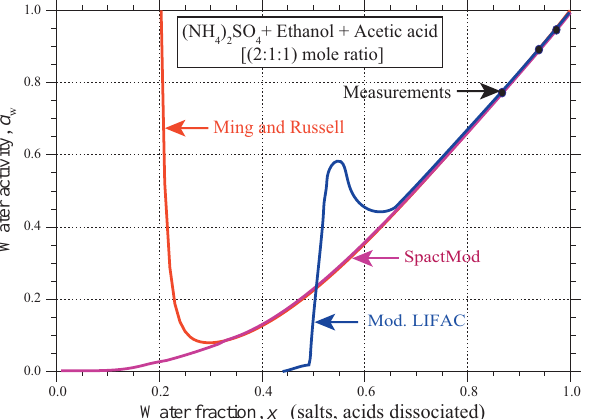
Figure 11. Importance of different interactions in the aqueous so- lution composed of NaCl + (NH 4 ) 2 SO 4 + ethanol + malonic acid [1:1:1:1 (mole